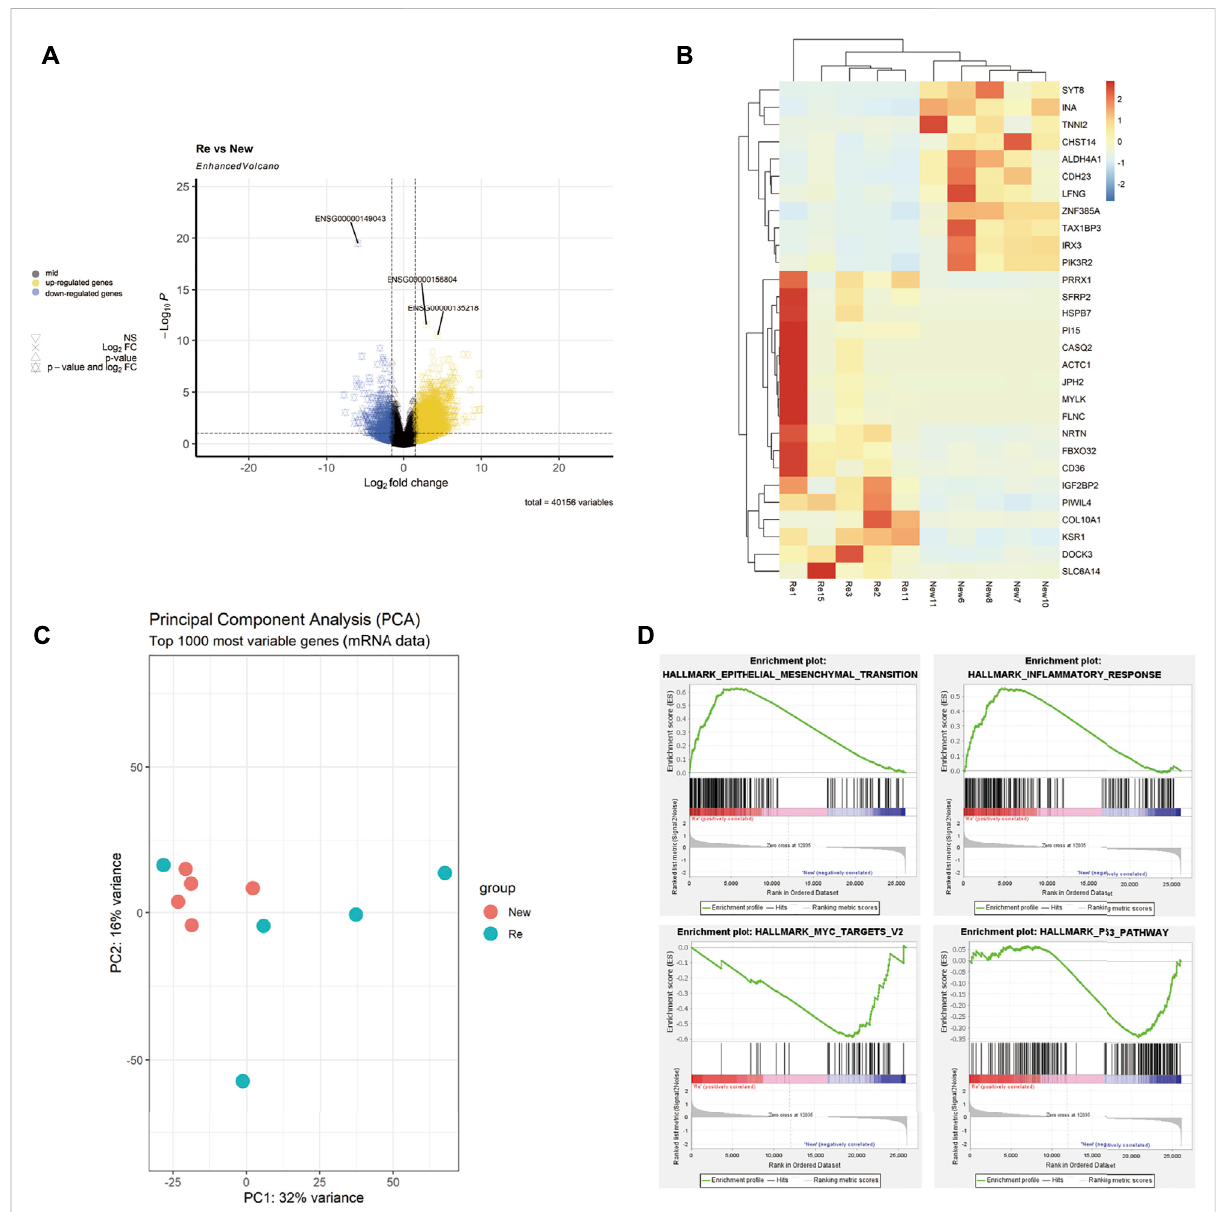
FIGURE 1 Description of mRNA-seq analysis results of 5 recurrent vs. 5 primary tumors. (A) A Volcano plot showing the differentially expressed genes (DEG) inrecurrentversusprimary bladdertumors (Re: Recurrent, New: Primary), DEG:| Log2Foldchange| > 1,P-FDR < 0.05. (B) A Heatmap showing the top 30 signi fi cantly differentially expressed genes in the recurrent versus primary bladder tumors. (C) The PCA analysis showing that most recurrent tumors were separated from the primary tumors. (D) Gene set enrichment analysis (GSEA) showing that gene expression levels of “ EMT ” and “ In fl ammatory Response ” were positively correlation with the recurrent tumors, while genes of “ Myc target v2 ” and “ P53 pathways ” were negatively correlated with the recurrent